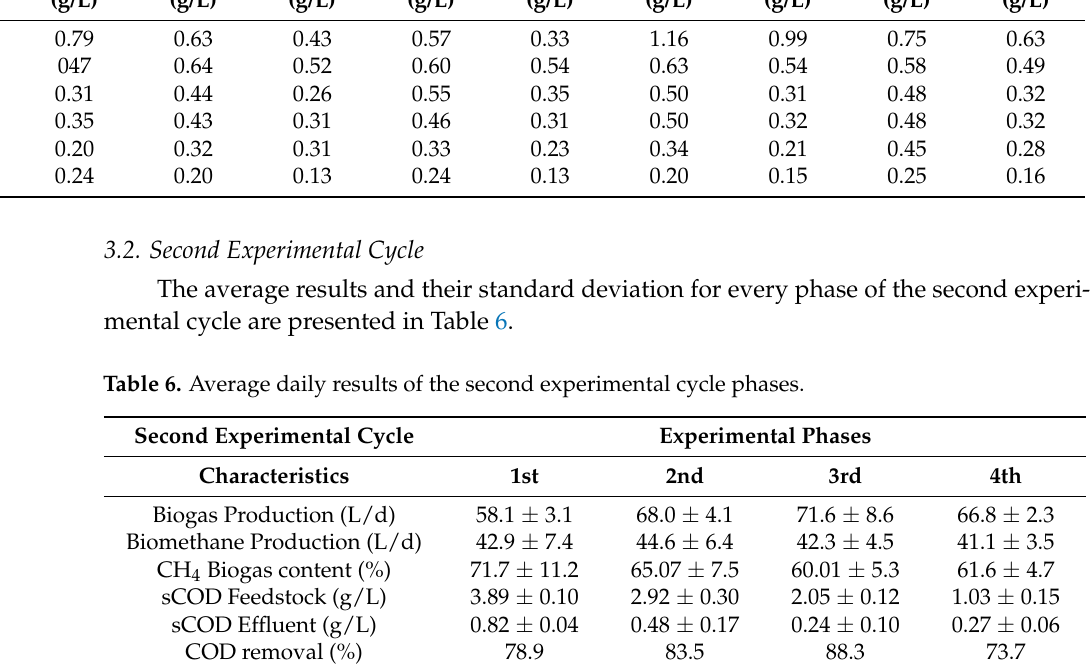
Table 5. Average daily TSS and VSS concentration in feedstock, reactor’s compartments and effluent. Compartment a